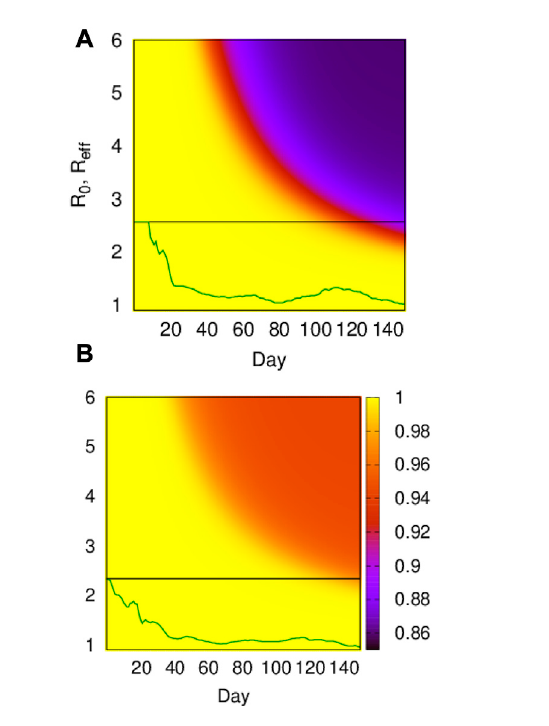
FIGURE 6 (A, B) R 0 and R eff trajectories superimposed on business-as- usual model forecasts of SES relative employment (colour spectrum). R 0 trajectories (straight black line) indicate model outcome if transmission rates on 1 March 2020 had remained unchanged, whereas R eff trajectories (green lines) show actual SES histories. (A) Fresno, (B) Los Angeles-Glendale-Long Beach. Note that in both (A, B) , the unmitigate R 0 trajdctories would cross the threshold or tipping point (transition between yellow and redder regions) leading to accelerated job